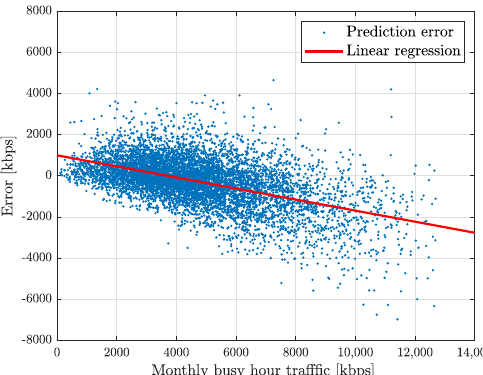
Figure 6. Error vs. monthly busy-hour traffic (ANN–LSTM, case